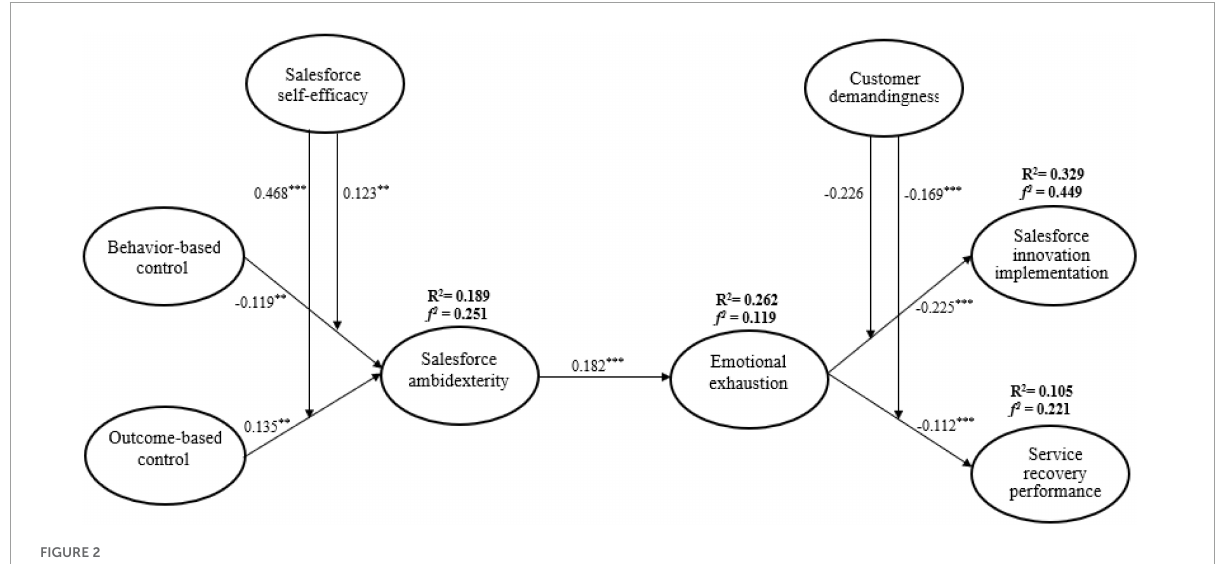
FIGURE2 Results of hypotheses. **, ***Indicate the level of